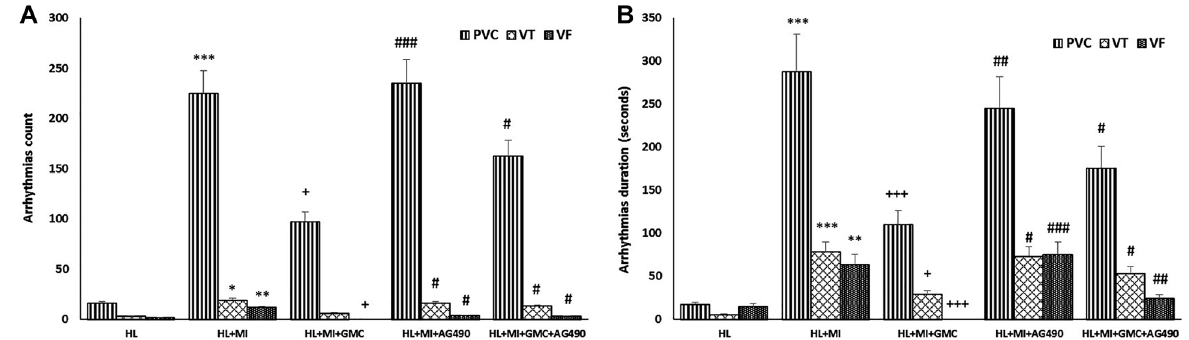
Figure 2: The effects of GMC administration on the number (A) and duration (B) of reperfusion-induced myocardial arrhythmias and their reversal by AG490 in hyperlipidemic (HL) rats.